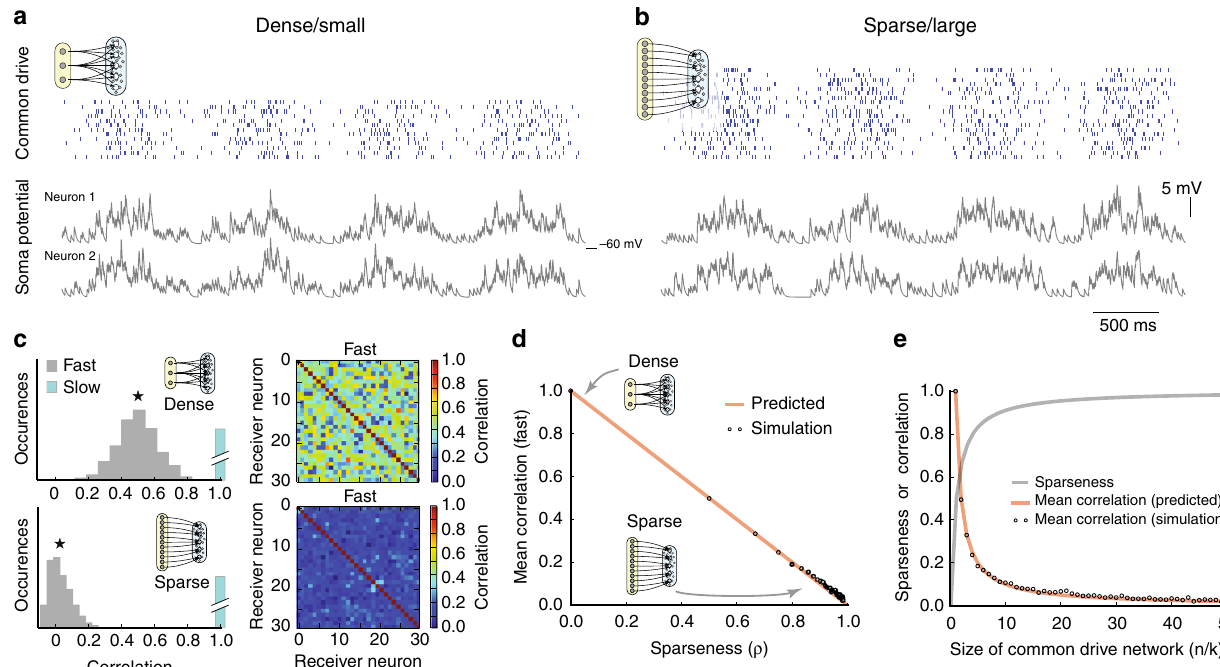
Fig. 2 Synaptic correlation depends on network size and architecture. a Oscillatory spiking activity of the motor rhythm was imitated as an inhomogeneous poisson process with sinusoidal rate in a small common drive model network (raster) projecting via divergent connections results in a rhythmic V m of target neurons with substantial correlation on both fast and slow timescales (below/above 400 ms – timescale). Sample traces shown (gray), R = 0.5 on fast timescale. b Sparse convergent connectivity from a larger premotor network gives weak correlation ( R = 0.02, fast). c Distribution of fast correlation for receiving pairs with dense/small (top) versus sparse/large connectivity (bottom) for the conditions in a ( n = 20 source cells) and b ( n = 500). Correlation matrix for the receiving population shown in colors to the right. The slow correlation remains 1 in both topologies (cyan). d Mean fast correlation (star in c) is inversely linked to sparseness (circles). The expected correlation (orange, ‘ predicted ’ ) is the fraction of common connections over the total number of synaptic input. e Sparseness (gray) increases and fast correlation ( ‘ predicted ’ , orange, ‘ simulated ’ circles, as in d ) decreases with network size. The in – degree is kept constant ( k =